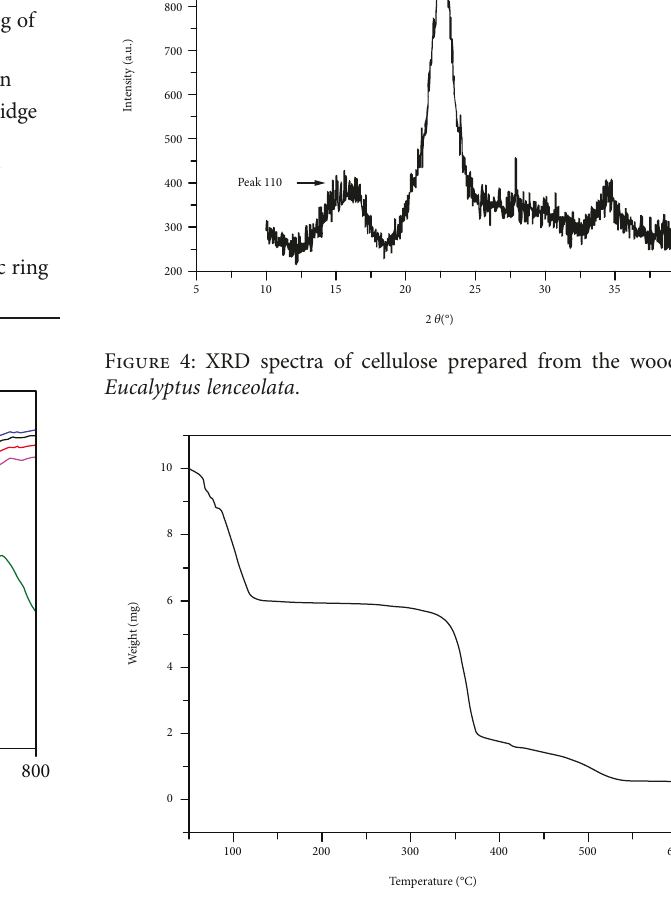
Figure 3: FTIR spectra at di ff erent stages of cellulose extraction from the wood of Eucalyptus lenceolata .